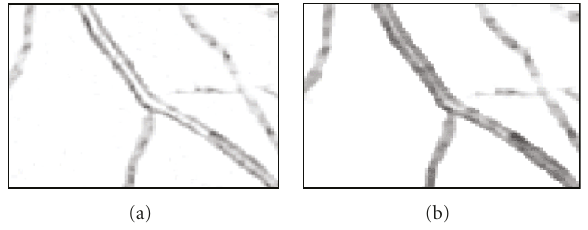
Figure 8: Morphological correction: (a) vessels after contrast enhancement, (b) vessels after morphological